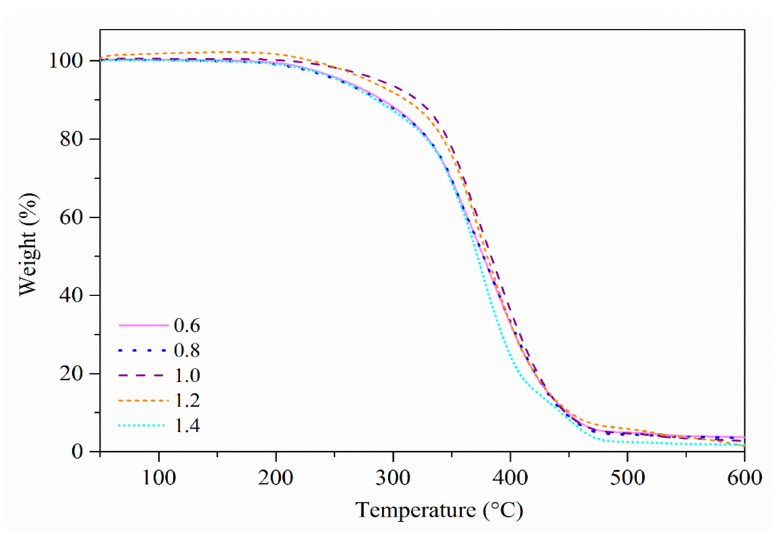
Figure 6. Thermogravimetric analysis (TGA) curves of EJO/MHPA with various ratios of anhydride to